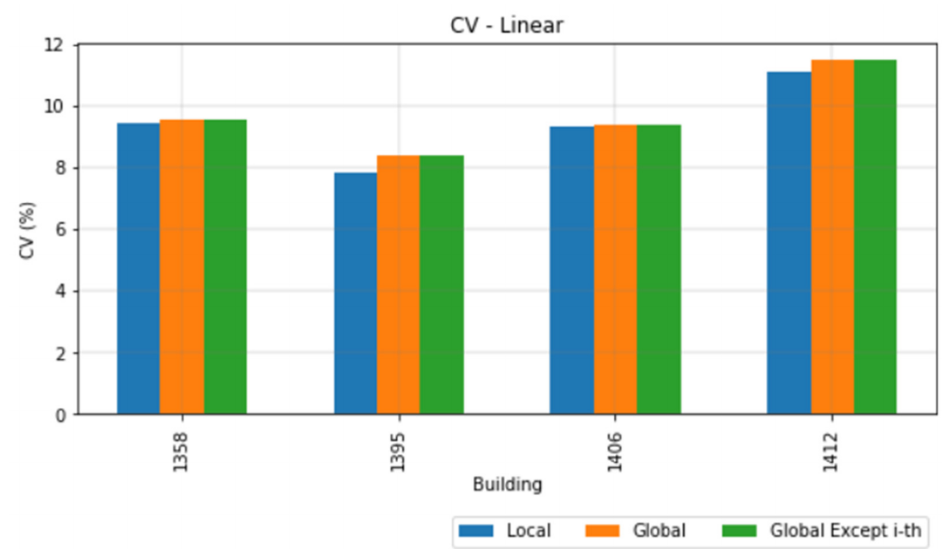
Figure 18. Comparison between the CV on test set obtained using Linear method with different modalities: local, global and global trained using all the available data except the energy consumption related to the selected building.